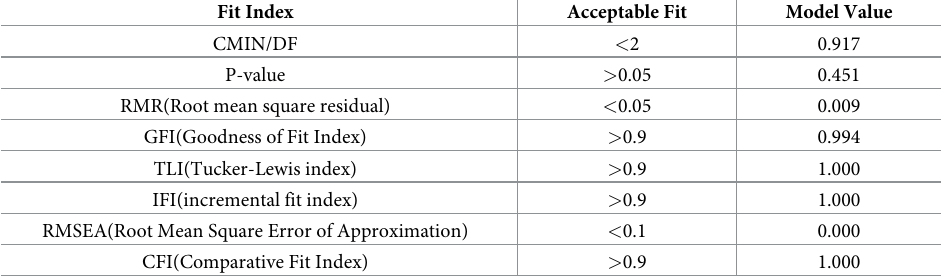
Table 7. Fit statistics for SEM